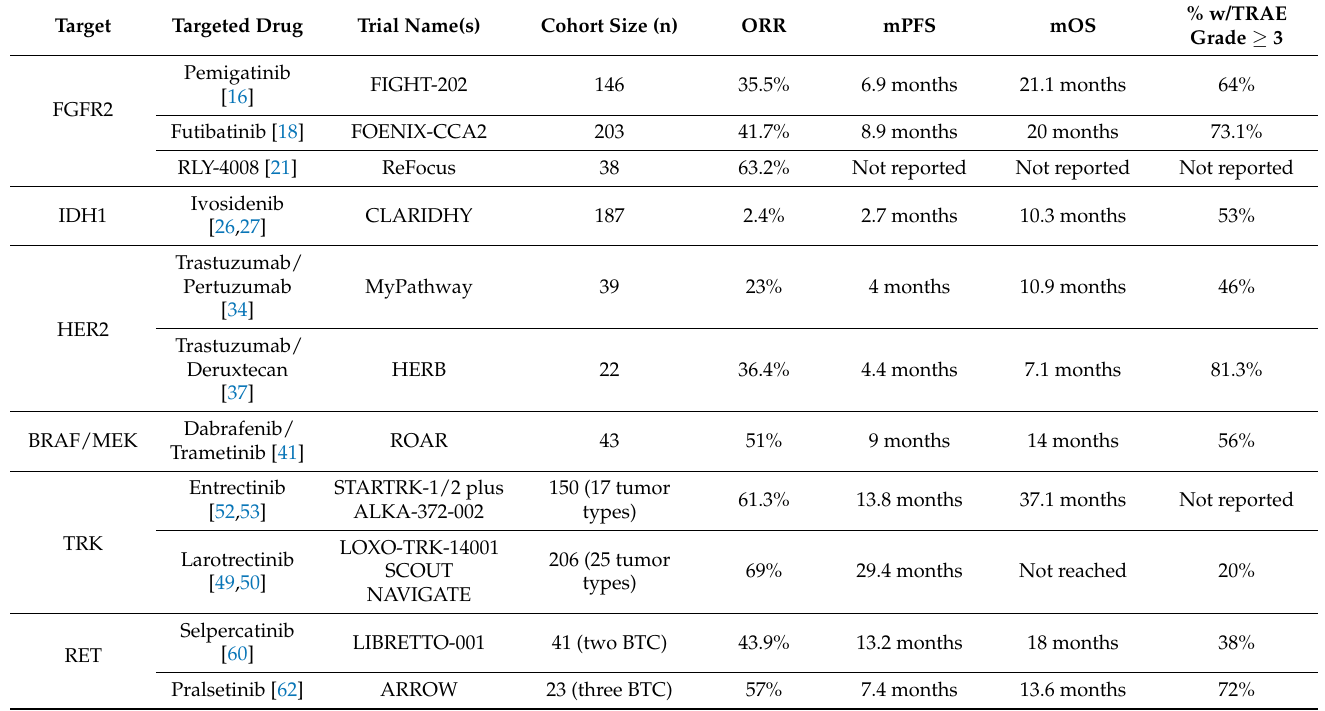
Table 1. Approved targeted therapies and updated trial